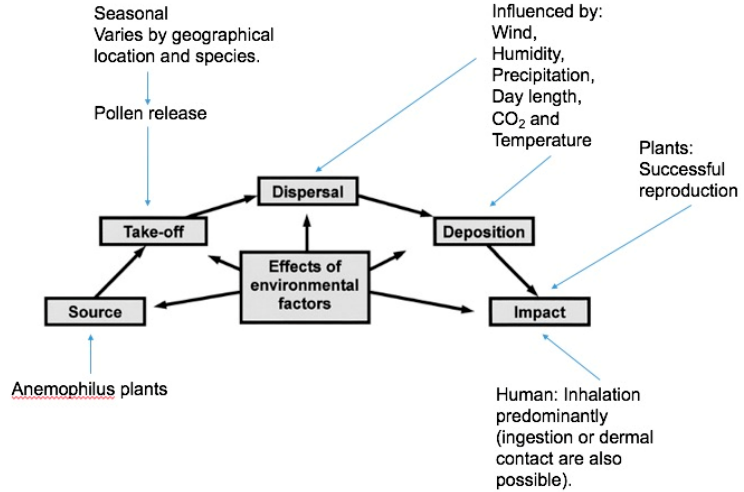
Figure 1. The aerobiology pathway of pollens, adapted from [21].